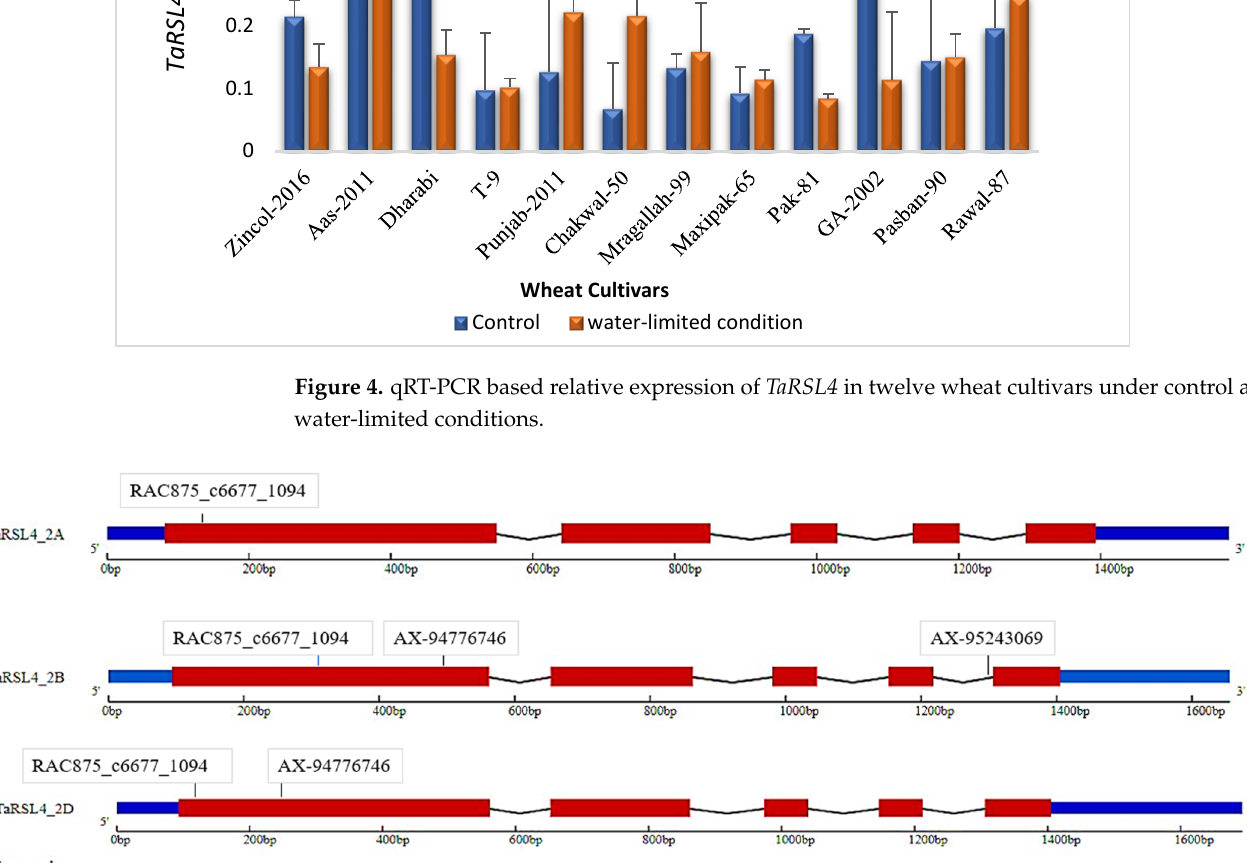
Figure 5. Gene structure of TaRSL4 homoeologues showing position of their respective SNPs.